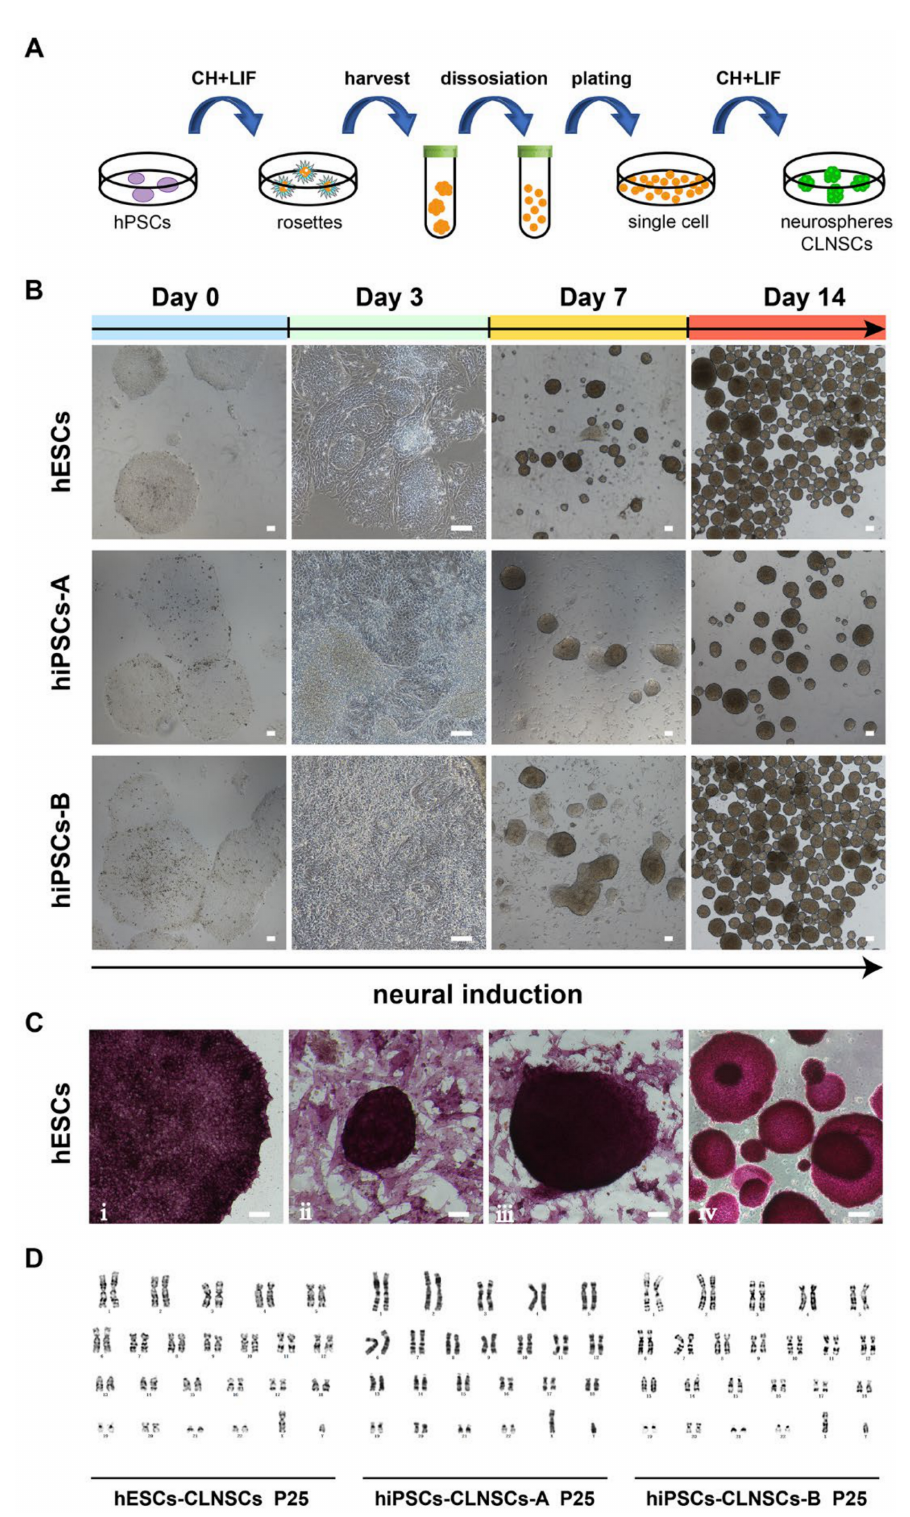
Figure 1. Generation of CLNSCs derived from hPSCs. ( A ) Schematic diagram of hPSCs to CLNSCs differentiation. ( B ) Morphology changes in three hPSC cell lines during neural induction at different times, scale bar: 100 µ m. ( C ) AP staining of hESCs cultured in CL medium. i: Day 0; ii: Day 3; iii: Day 7; iv: Day 14. Scale bar: 100 µ m. ( D ) Karyotype analysis of the CLNSCs derived from hPSCs (Passage 25), showing normal